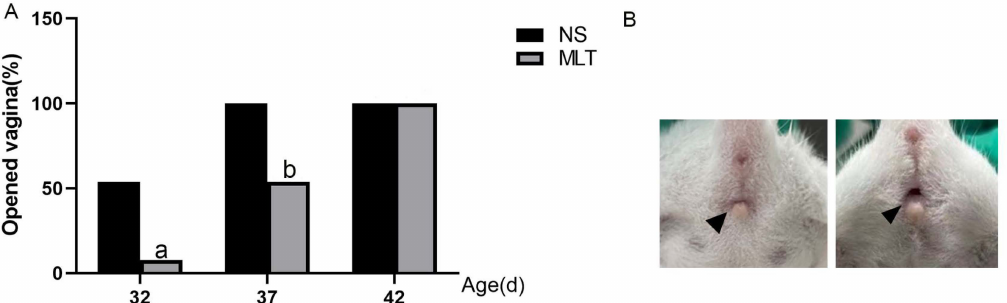
Figure 1. Melatonin’s effects on female mice’s vaginal opening rate (n = 13). ( A ) Vaginal opening rate. ( B ) Vaginal photo. ( Left ): vagina closed; ( Right ): vagina open (Black triangle). a: p < 0.05 vs. 32 dNS; b: p < 0.05 vs. 37 dNS; 32 d, 32 days; 37 d, 37 days; 42 d, 42 days; NS, normal saline; MLT, melatonin.